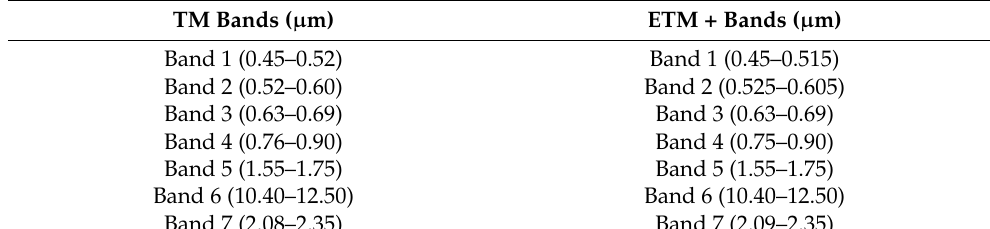
Table 2. Landsat TM/ETM + spectral bands.